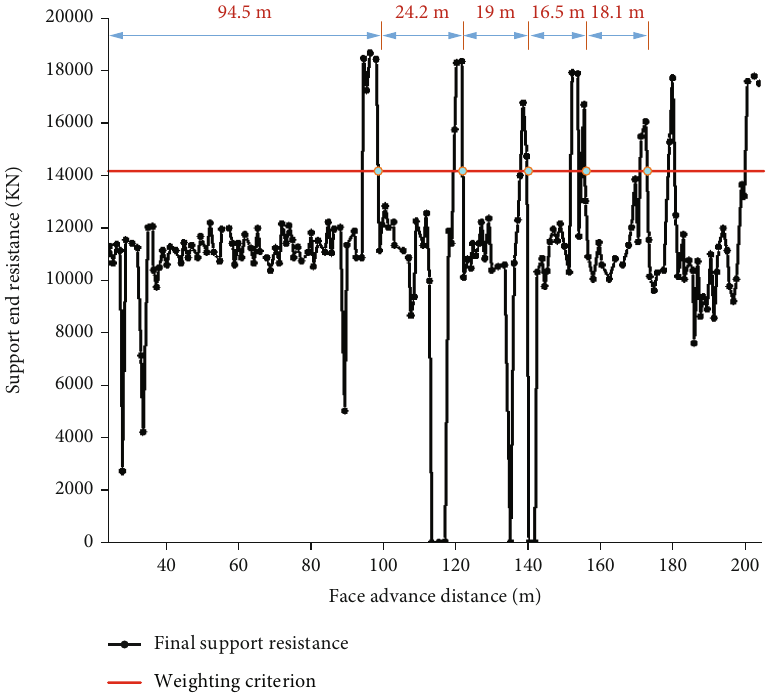
Figure 2: Law of the end resistance variation